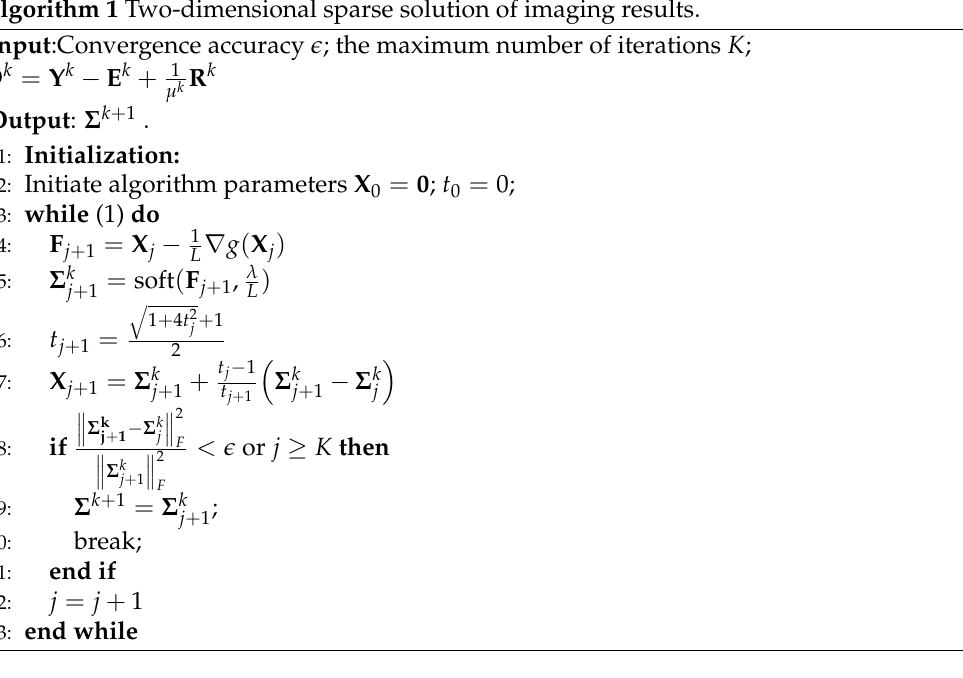
Algorithm 1 Two-dimensional sparse solution of imaging